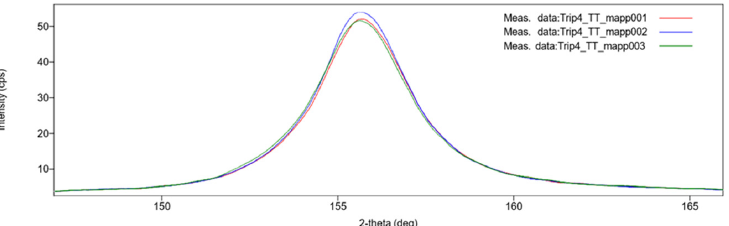
Figure 10. Austenite peaks (220) measured at three points for the TRIP 4 steel sample after heat treatment. Table 4. Retained austenite fraction in heat-treated samples, V γ 1 . Sample Code